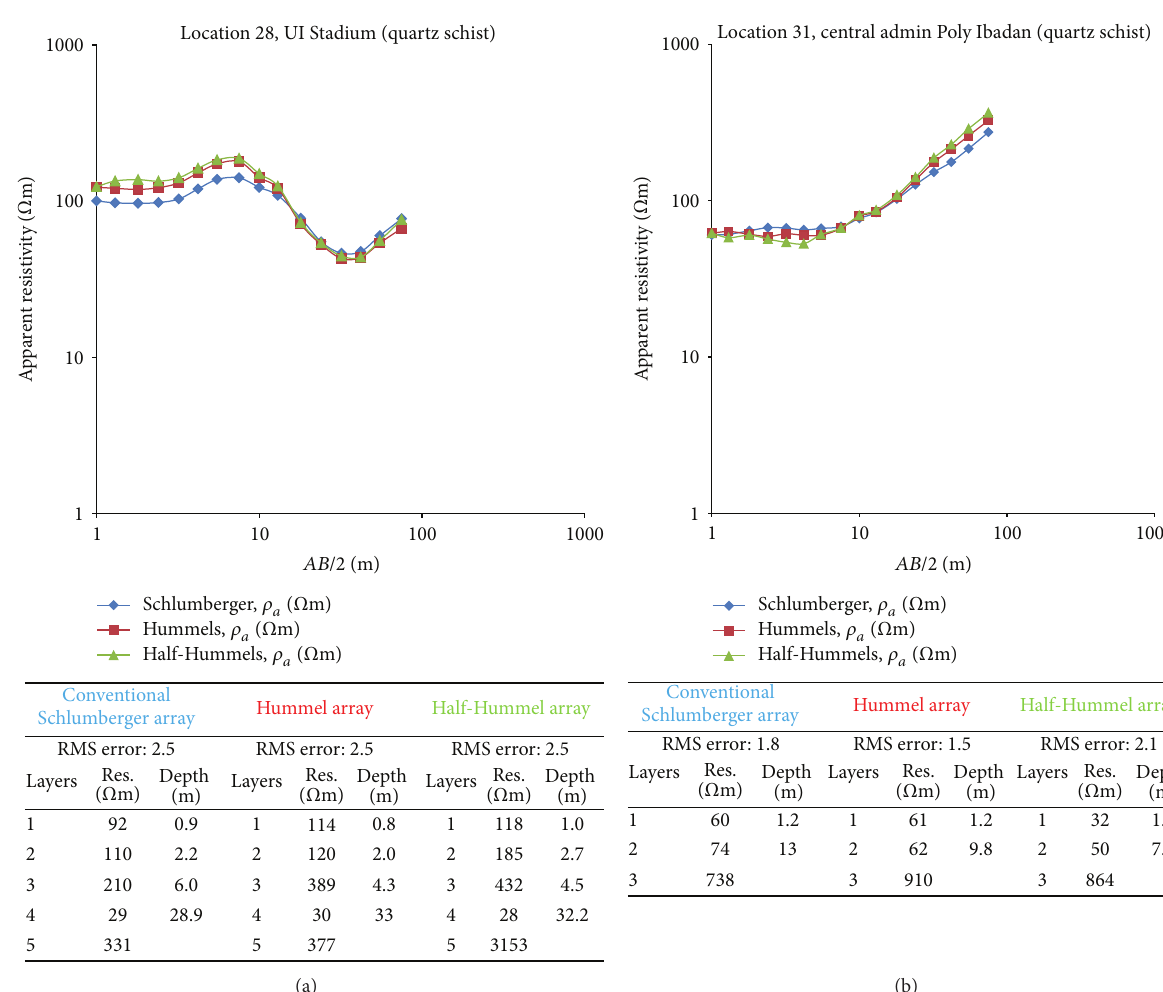
Figure 5: Comparison of results obtained from the interpretation of field data collected using the different array methods at VES stations on quartz schist for (a) location 28, University of Ibadan, and (b) location 31, the Polytechnic Ibadan.